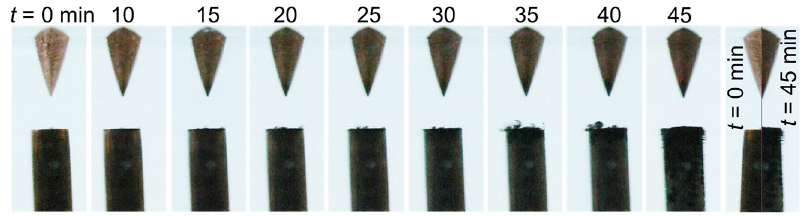
Figure 4. Temporal evolution of the liquid-electrode zone for case 1 ( σ 0 = 2 µS/cm).